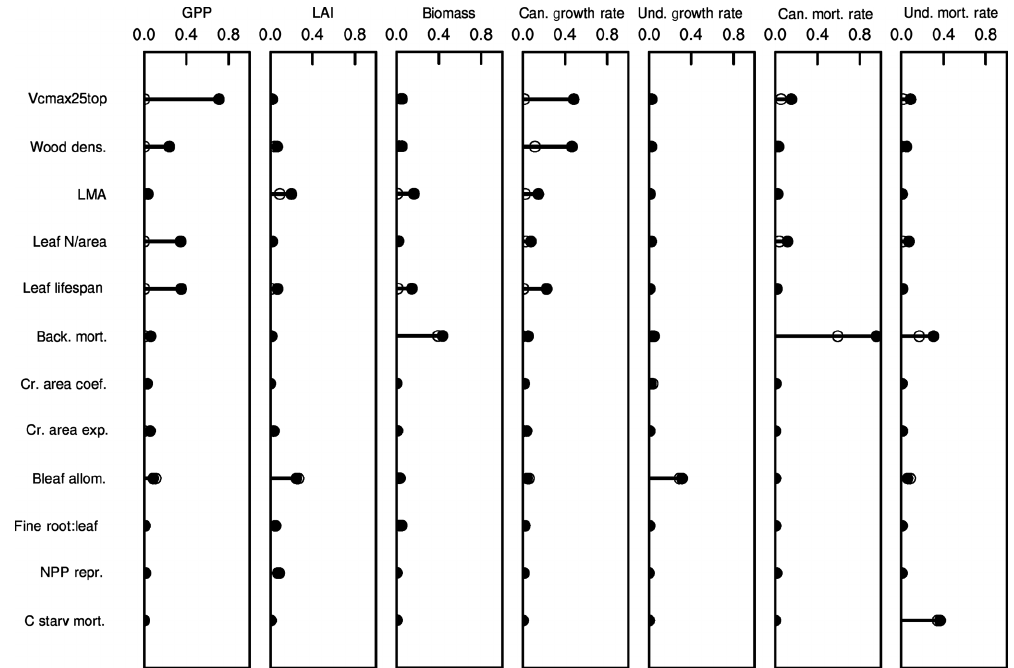
Figure 8. Variance decomposition of trait control on ecosystem states and vital rates. Shown are the fractions of variance explained by each of the 12 traits for seven ecosystem variables. Filled circles and associated lines show the maximum potential fraction of variance explained by each trait, without considering trait-trait correlations. Open circles show the minimum fraction of variance explained by each trait after first subtracting out the variance explained by all other